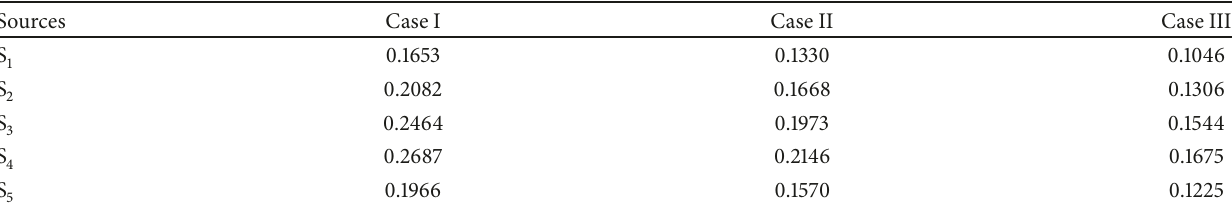
Table 24: WASPAS